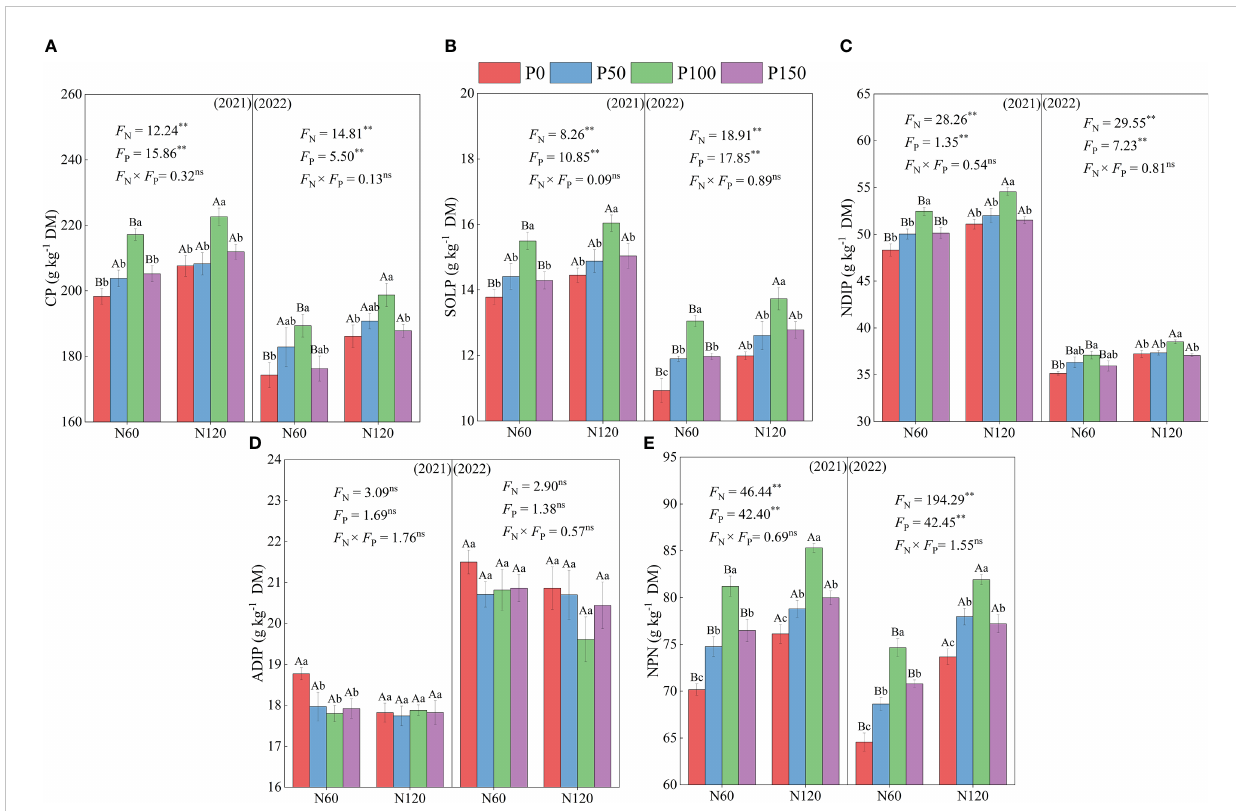
FIGURE 1 CP, crude protein (A) , SOLP, soluble protein (B) , NDIP, neutral detergent-insoluble protein (C) , ADIP, acid detergent-insoluble protein (D) and NPN, non-protein nitrogen (E) of alfalfa during difference nitrogen and phosphorus combined fertilization in 2021 to 2022. All the values were the means of four replicates with standard errors. Different small letters indicate signi fi cant differences between different P fertilizer treatments under the same N application condition ( p < 0.05). Different capital letters indicate signi fi cant differences between different N fertilizer levels under the same P application condition ( p < 0.05). F N , F P and F N × F P represent the F value under the N application levels, P application levels and the interaction of N and P application levels, respectively. ns indicates no signi fi cant difference ( p > 0.05), * indicates signi fi cant difference ( p < 0.05) and ** indicates extremely signi fi cant difference ( p <